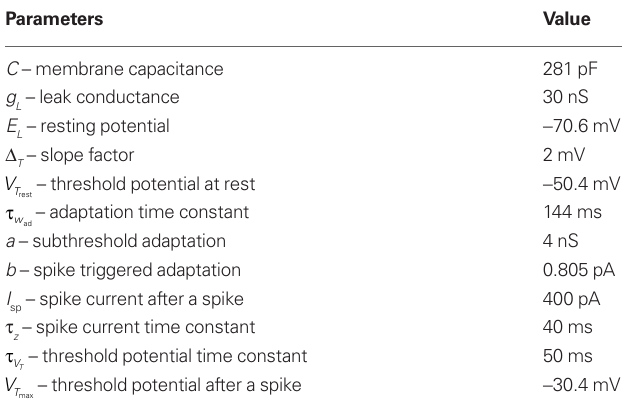
Table 1 | Parameters of the neuron model.